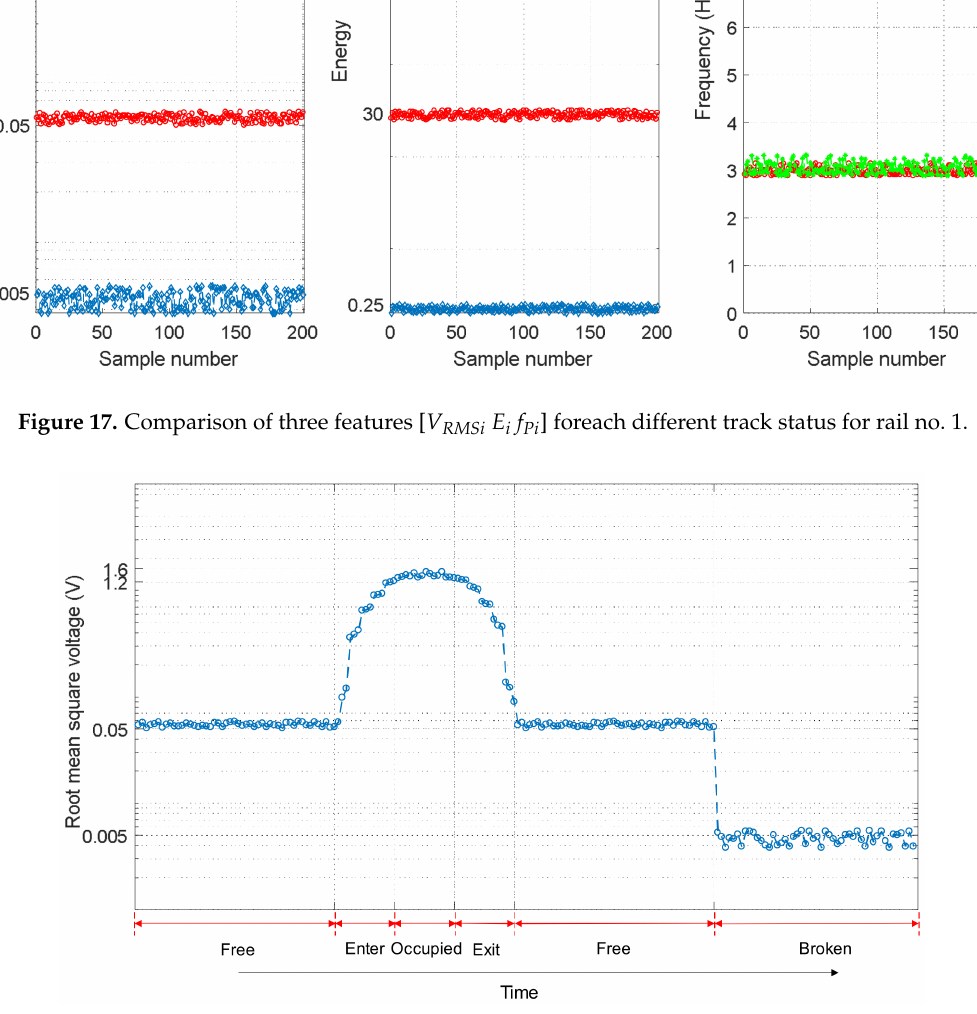
Figure 18. Example of a temporal trend for the feature V RMSi in a certain track section S i